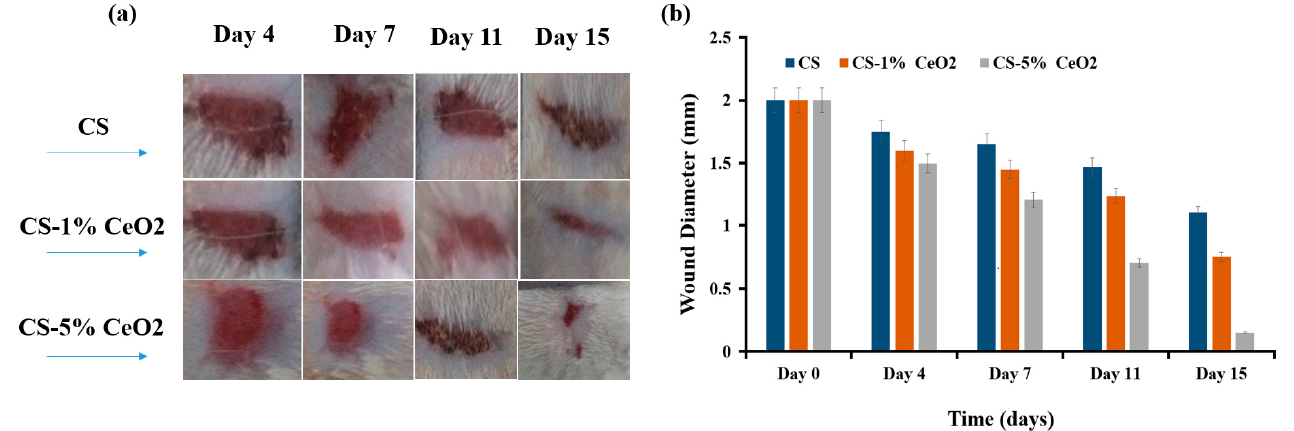
Figure 8. ( a ) Photographs representing the analysis of incision wound treatment with green synthesized CS-1% CeO 2 and CS-5% CeO 2 nanoparticles incorporated in chitosan hydrogel membrane groups. ( b ) Comparison of wound reduction in diameter.